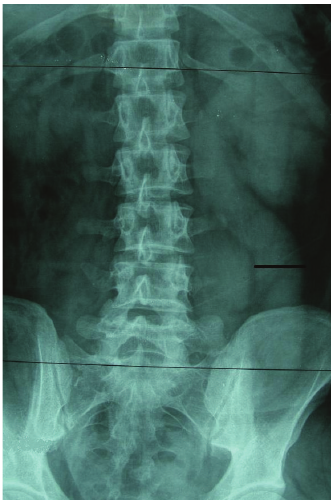
Figure 5: Postoperative intravenous